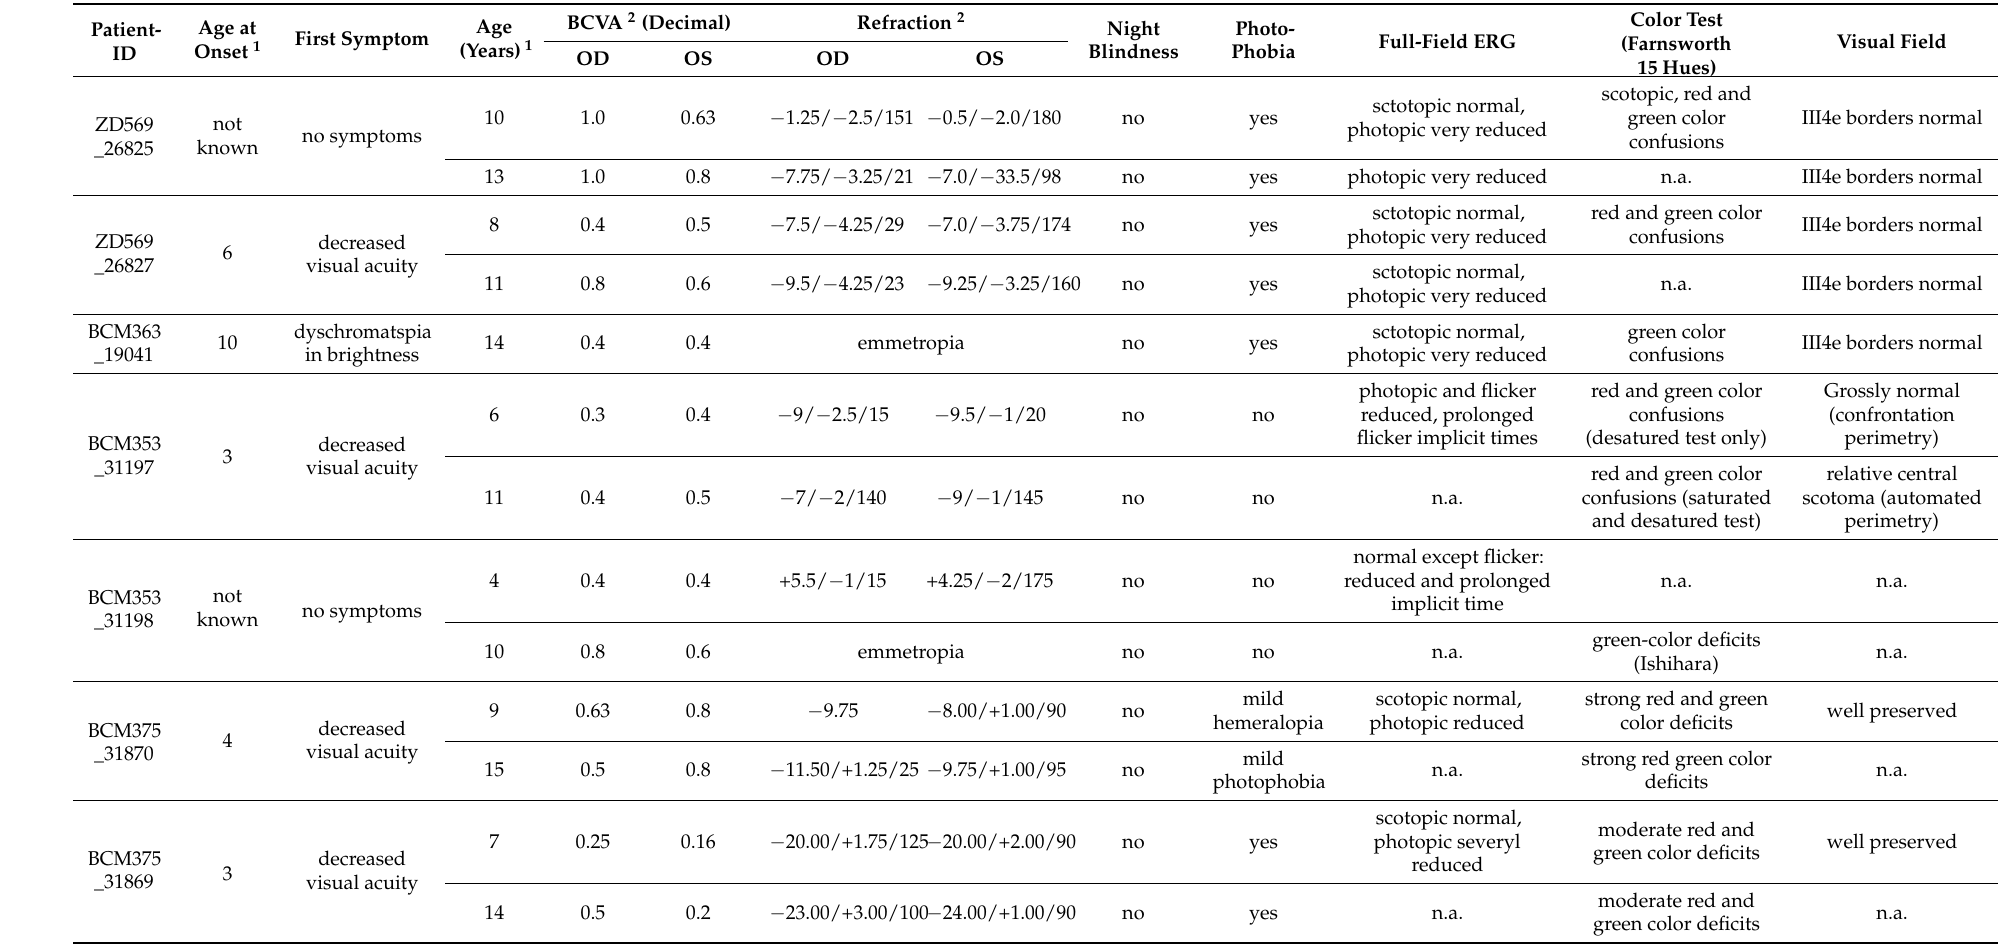
Table 3. Clinical findings including medical history of all